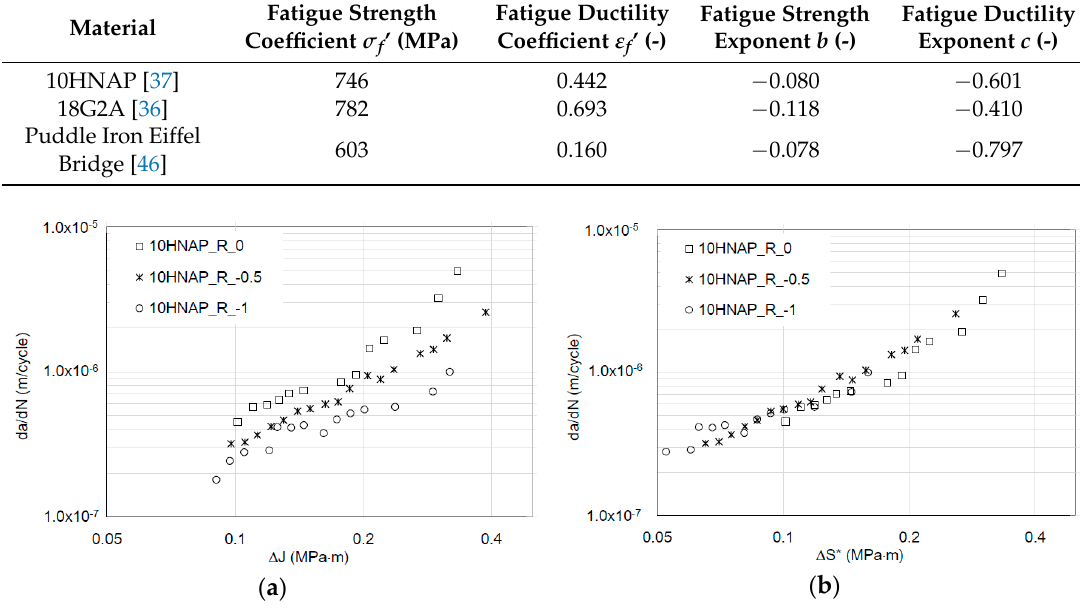
Figure 7. Fatigue crack growth curves for 10HNAP steel ( a ) based on the Δ J crack driving force (based on data from [37]) and ( b ) based on the new, averaged Δ S* crack driving force.